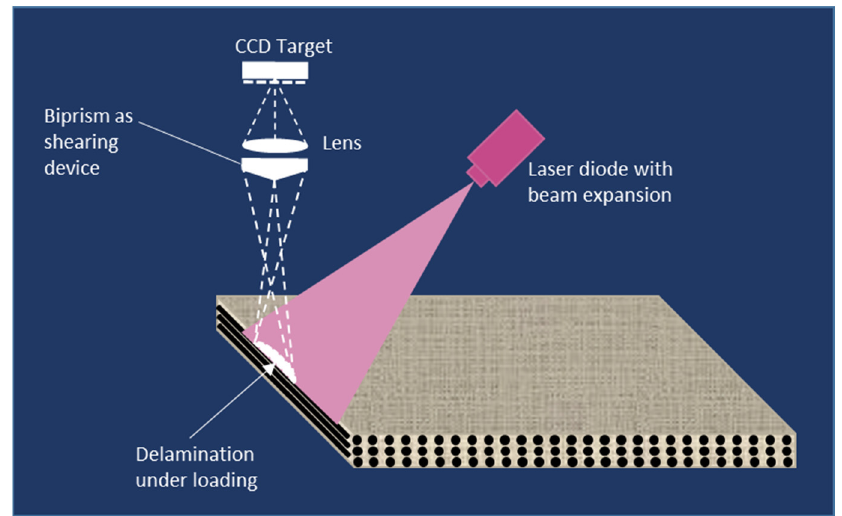
Figure 4. Principle of shearography.